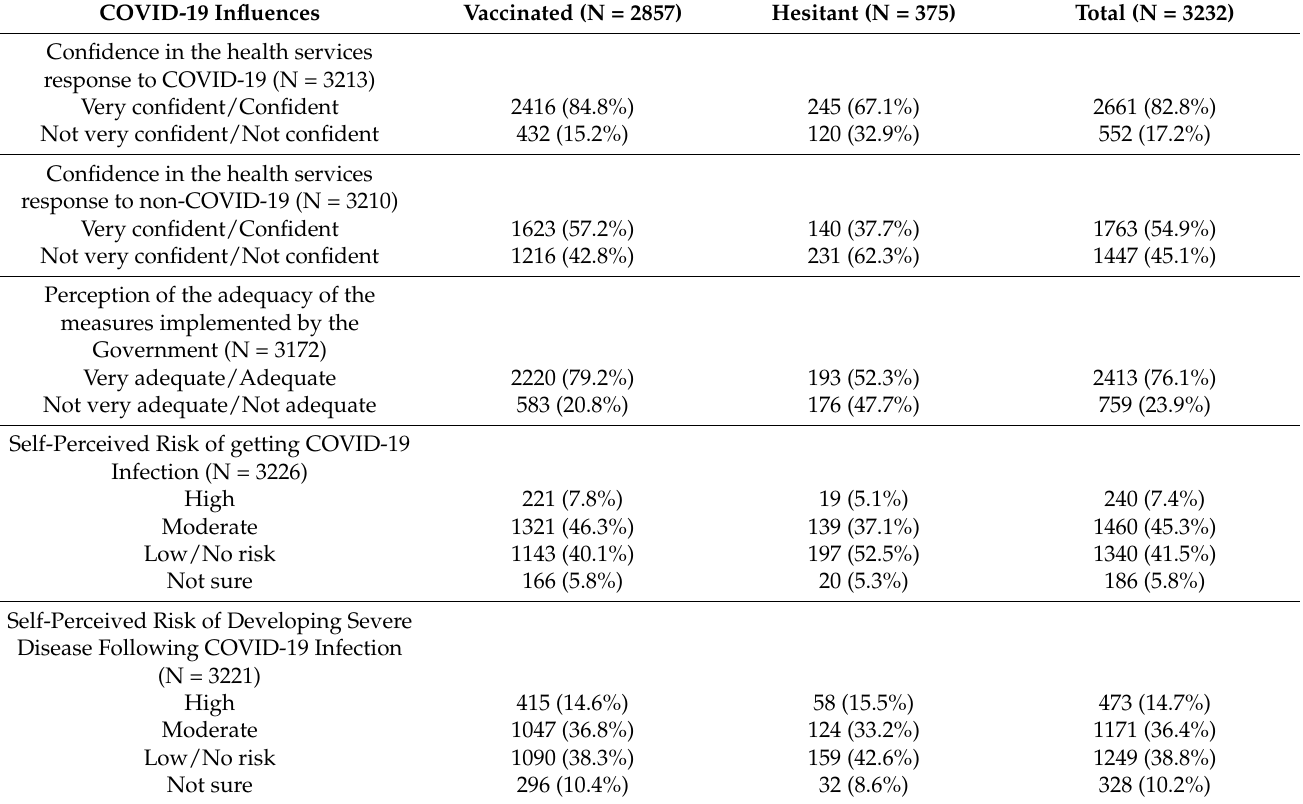
Table 4. Sample characteristics according to COVID-19 influences.